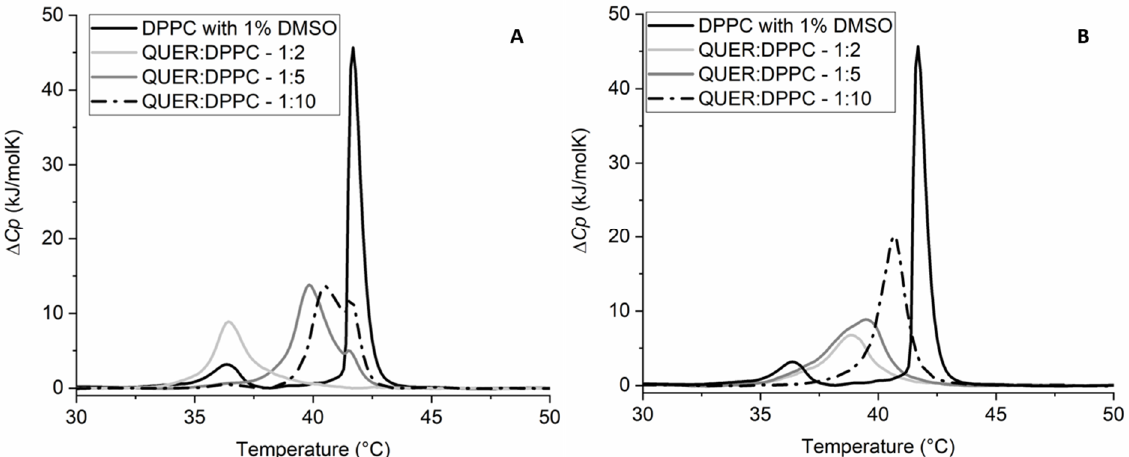
Figure 5. DSC thermograms of 1,2-dipalmitoyl- sn -glycero-3-phosphatidylcholine (DPPC) liposomes in 20 mM HEPES (pH = 7.0) buffer with or without the addition of 1% dimethyl sulfoxide (DMSO) (negative controls) and in the presence of quercetin (QUER) at different n compound : n DPPC molar